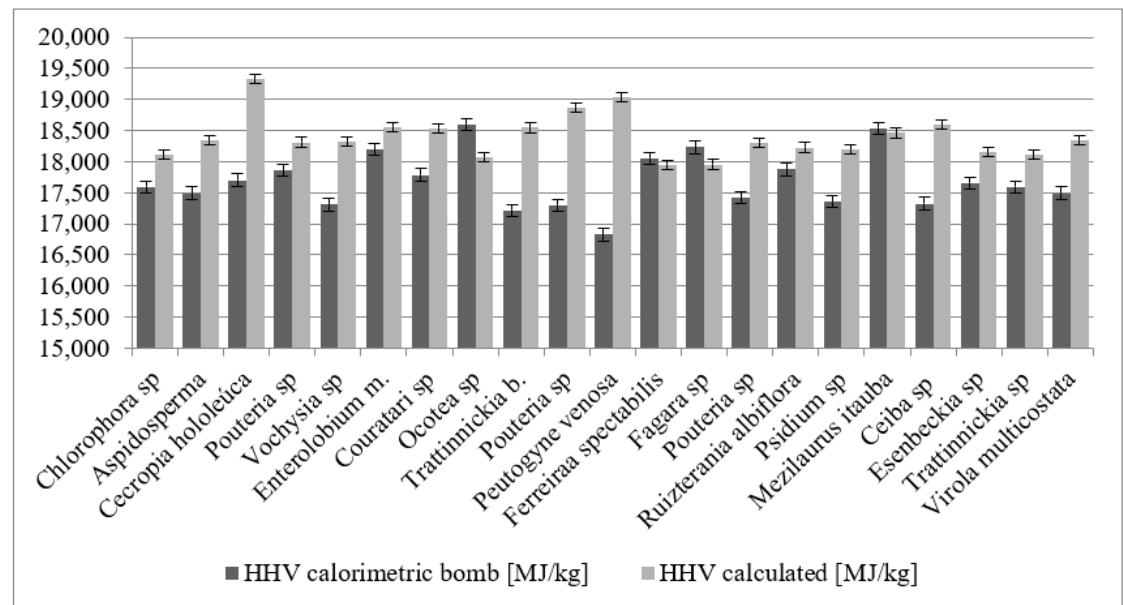
Figure 2. Comparison of the HHV average from different woods determined in a calorimeter pump and calculated empirically (Equation (1)), considering only lignin content.